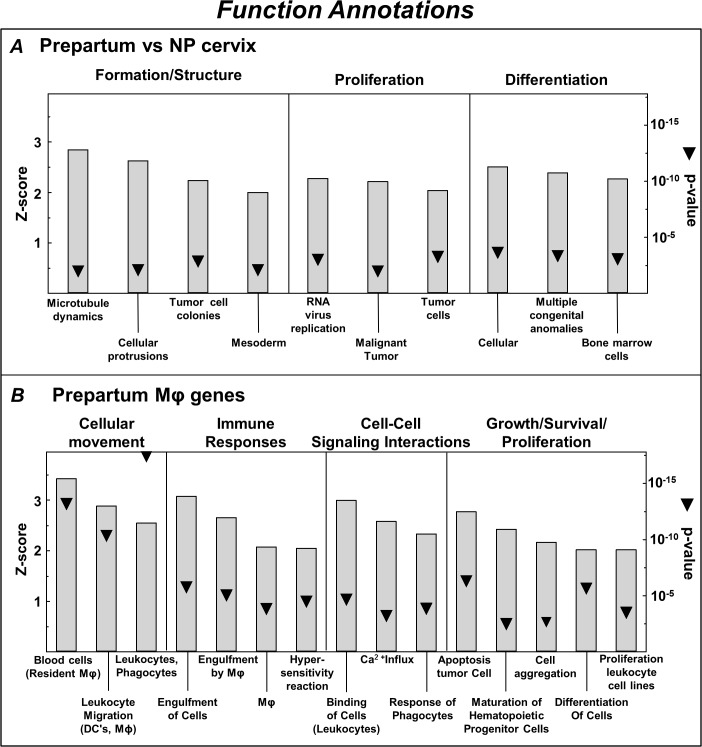
Functional annotations from Ingenuity Pathway Analysis (IPA) of increased expression of genes in the whole cervix from prepartum (D21) versus nonpregnant (NP) rats (A) and Mφ genes exclusively up-regulated in the cervix (whole vs Mφ-depleted) from prepartum rats (B).Categories of Function (Headings) and Annotations (histogram labels) consist of IPA designations based upon Z-score rank (threshold>2 estimates proportion of genes that were increased within each annotation; p < 0.01). Categories were broadened (Subheadings combined) to eliminate redundancy in IPA assignment of genes. p value is indicated by triangles. Mφ data analysis included expression of genes that were most divergently regulated, exclusively and in common, in cervices from D21 prepartum and NP groups (ratio of fold > 2 or < 2, D21 vs NP groups).